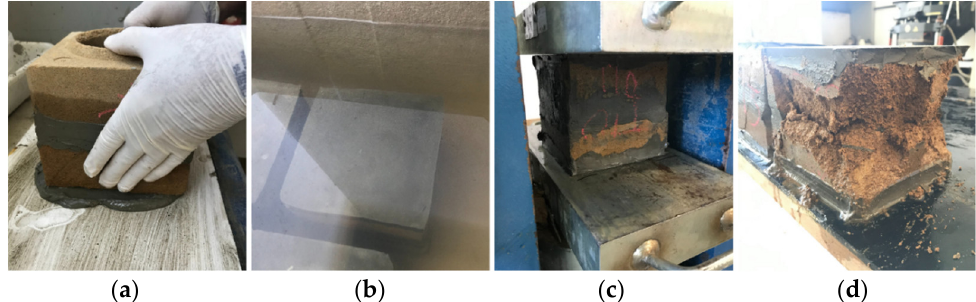
Figure 5. ( a ) Brick capping; ( b ) brick submerged in water; ( c ) compressive strength; ( d ) brick after compression.